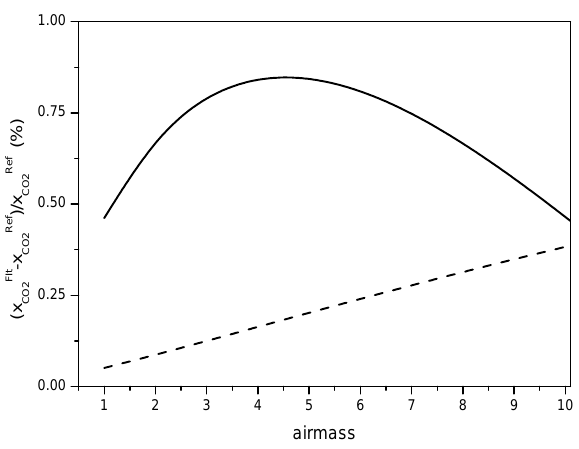
Fig. 3. Influence of the spectral resolution on the errors in CO 2 vmr retrieved neglecting line-mixing effects. The results are for MOPD’s of 2cm (black line), 10cm (blue line) and 50cm (red line). The upper (full lines) and lower (dashed lines) set of three curves refer to Band#1 (4765–4915cm − 1 ) and Band#2 (6160–6270cm − 1 ), respectively.